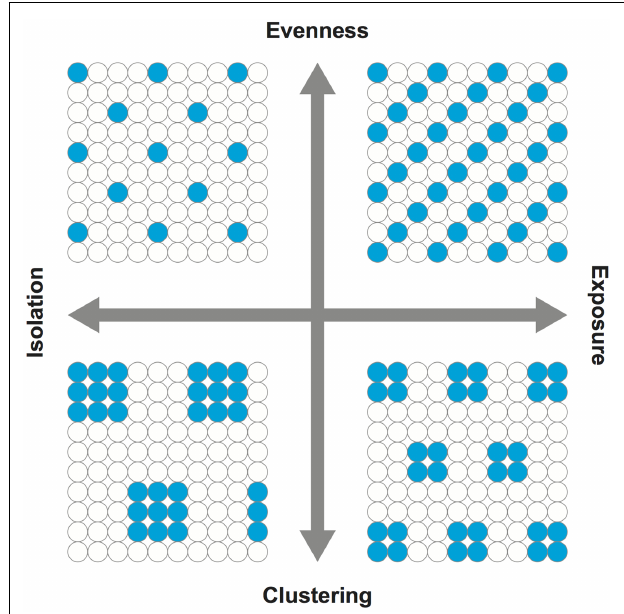
FIGURE 1 | Dimensions of segregation . Adopted from Reardon and O’Sullivan (17). In capturing the spatial patterns of population groups, evenness is the opposite of clustering while isolation is the opposite of exposure. In simplest forms, the upper right quadrant may be conceived as a possible scenario for integration or diversity, whereas the lower left quadrant for